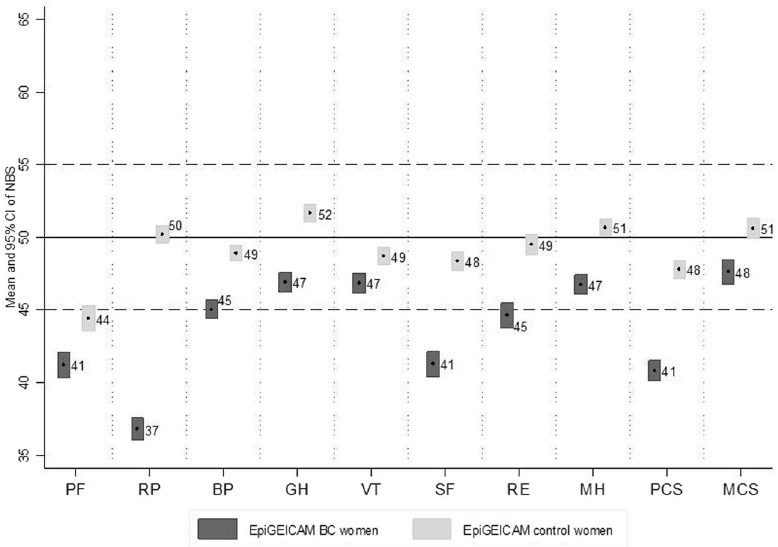
Figure 1. SF-36 means and 95% CI of norm-based scores of EpiGEICAM BC cases and controls. Values under 50 represent a worse perception than the reference population and values over 50, a better perception. All p-values < 0.001. BC:Breast cancer; NBS:Norm-based scores; PF:Physical Functioning; RP:Role-Physical; BP:Bodily Pain; GH:General Health; VT:Vitality; SF:Social Functioning; RE:Role-emotional; MH:Mental Health; PCS:Physical Component Summary; MCS:Mental Component